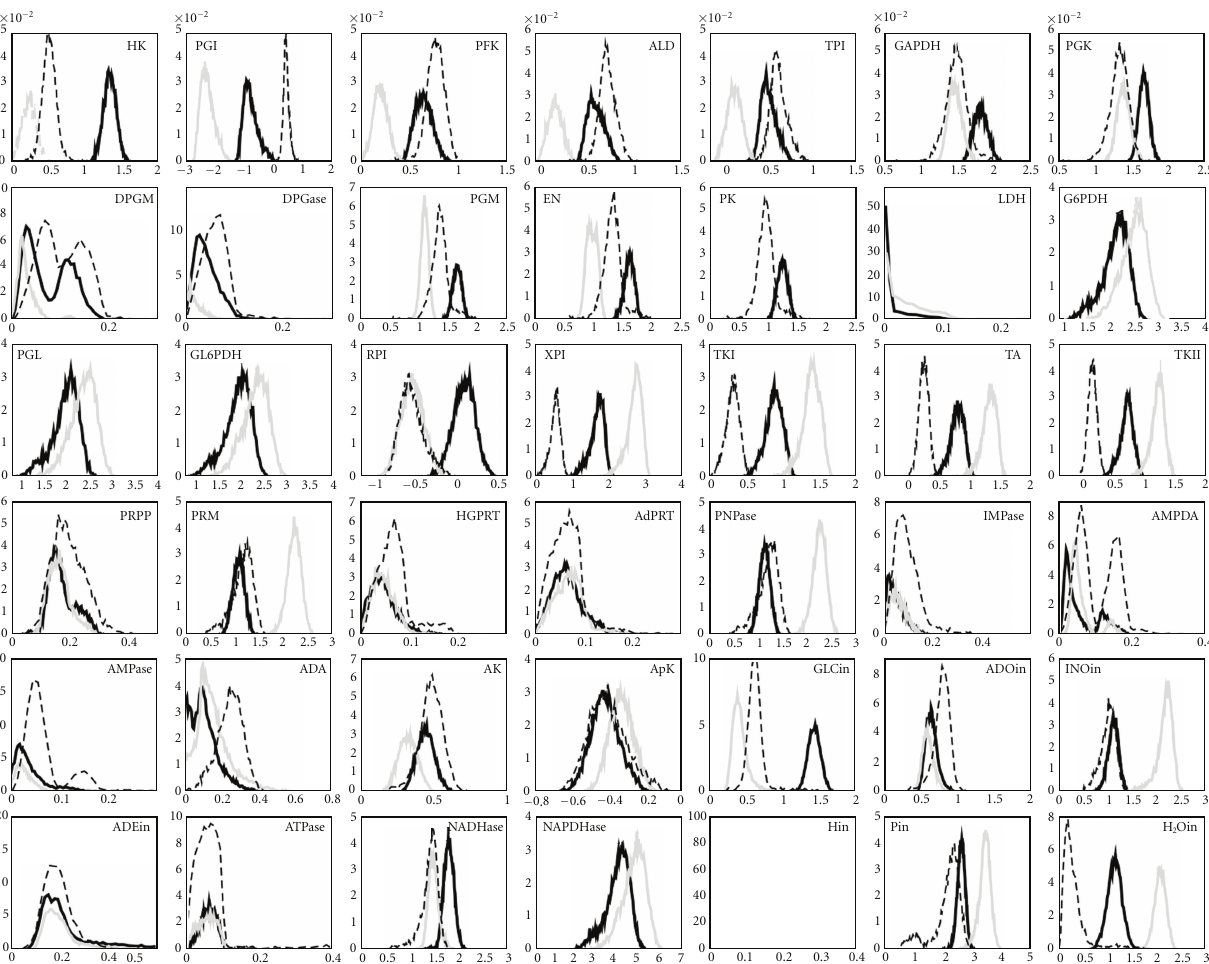
Figure 4: Distributions of di ff erential fluxes (measured for each reaction by the di ff erence between the direct and the reverse flux, when possible) for the healthy cell (thick black lines) and for the hRBC with knockout PK (thick gray lines) e G6PDH (dashed